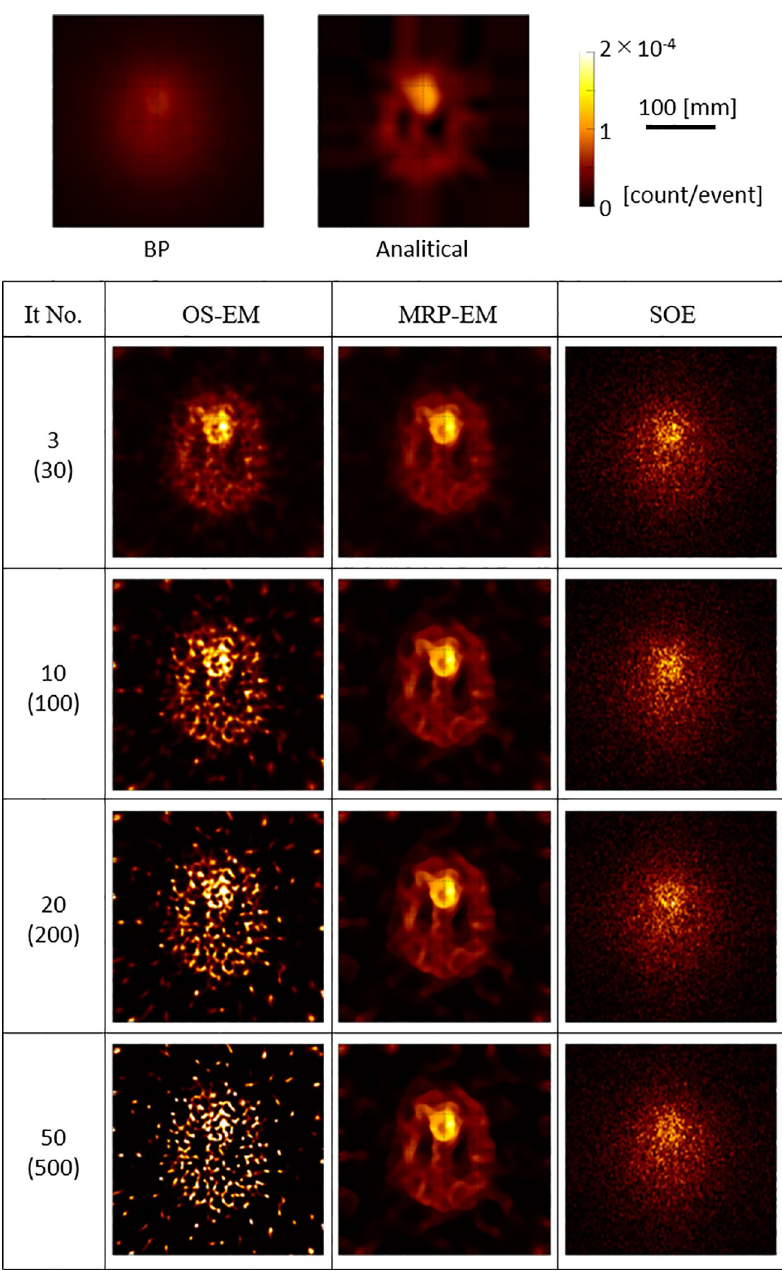
Fig 4. Images reconstructed using the various algorithms. Numbers in brackets denote the number of iterations for SOE (10 times more than for OS-EM and MRP-EM).